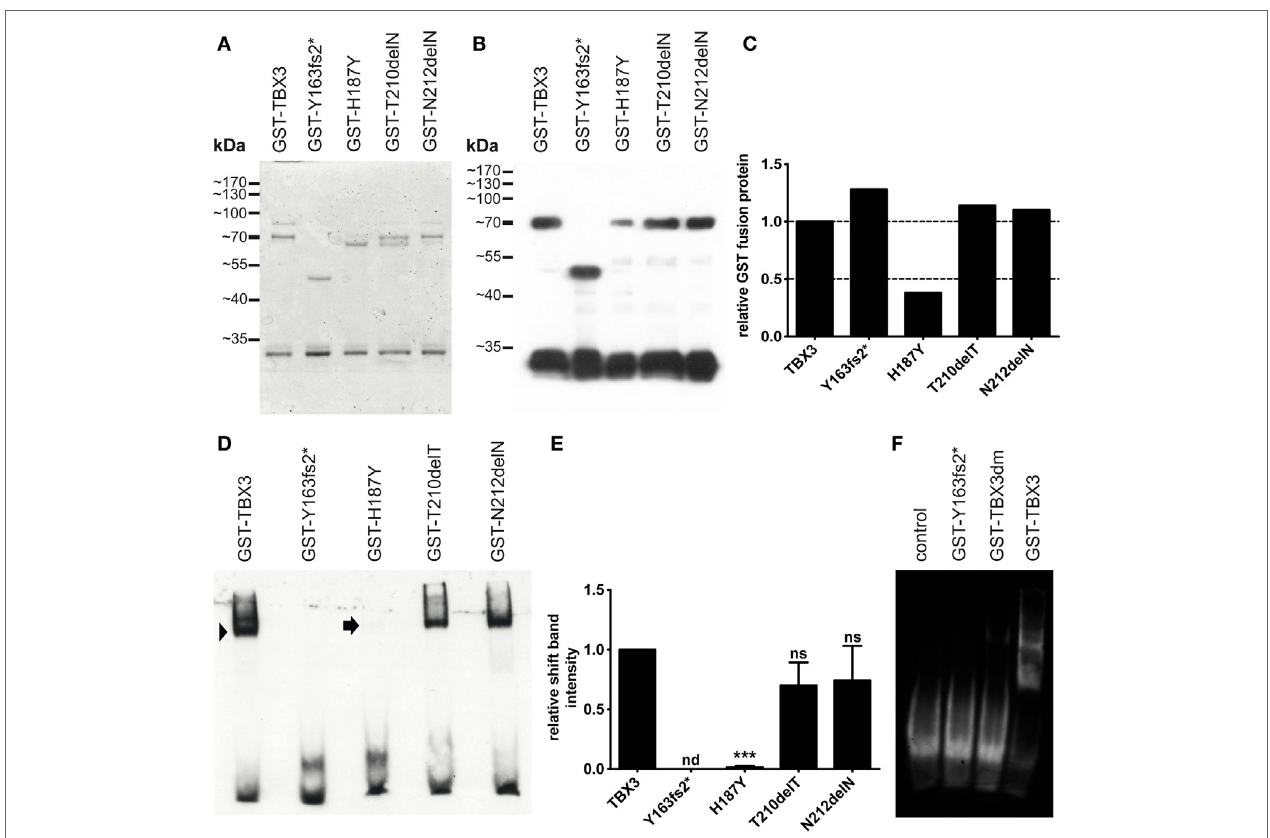
FigUre 2 | Bacterial expression and Dna binding of mutant TBX3 proteins . (a) GST-TBX3 protein variants after purification by glutathione affinity chromatography. Equal amounts of peak eluate protein were separated on a 10% SDS gel and stained with Coomassie Blue. Normal and point mutant protein fractions yielded a full-length band of 70 kDa [calculated molecular weight of the GST-TBX3(1–342) fusion protein is 65.4 kDa] and a band with ~30 kDa mobility. GST-TBX3(fs163fs2*) migrated with the expected mobility of ~48 kDa. (B) Anti-GST Western blot. A gel as shown in (a) was blotted and probed with anti-GST. Both the 70 and the 30-kDa band reacted with the antibody. Additional bands visible in the Coomassie-stained gel between 65 and 80 kDa were not immunoreactive. (c) Quantification of fusion band expression of the blot shown in (B) . (D) Electrophoretic mobility shift assay of GST-TBX3 protein variants. Equal amounts of fusion protein as determined in (c) were employed. The GST-TBX3(1–342) wildtypic fusion protein effectively shifted the consensus T-box binding element oligonucleotide (arrowhead), the point mutant derivatives T210delT and N212delN were slightly less efficient, H187Y yielded only a faint signal (arrow). (e) Quantification of shift-band intensity. The amount of oligonucleotide shifted by TBX3 was set to 1 ( n = 4). (n = not detected, ns = not significant) (F) EMSA comparison of p.Y163fs2* and the negative control mutant TBX3dm. Control is shift oligonucleotide